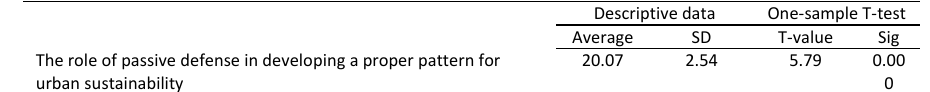
Descriptive data